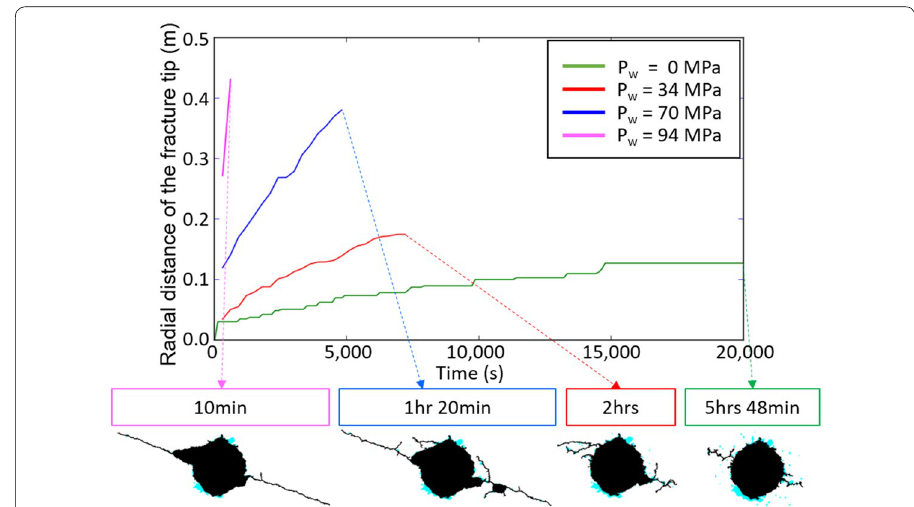
Fig. 18 Influence of the well pressure on fracture propagation (after both hydraulic pressure and thermal loading), for case stress state C, with h 1000 W m − 2 K − 1 . The four snapshots correspond to hydraulic = pressure P w of 94, 70, 34, 0 MPa. In this figure, black color corresponds to the wellbore and to separated pieces of rock matrix, cyan color corresponds to unseparated but severely damaged areas (more than 6 cracks cm − 2 ). Note that the fracture propagation is limited by the DEM model size, as a consequence, the radial distance of the tip cannot exceed 41.5